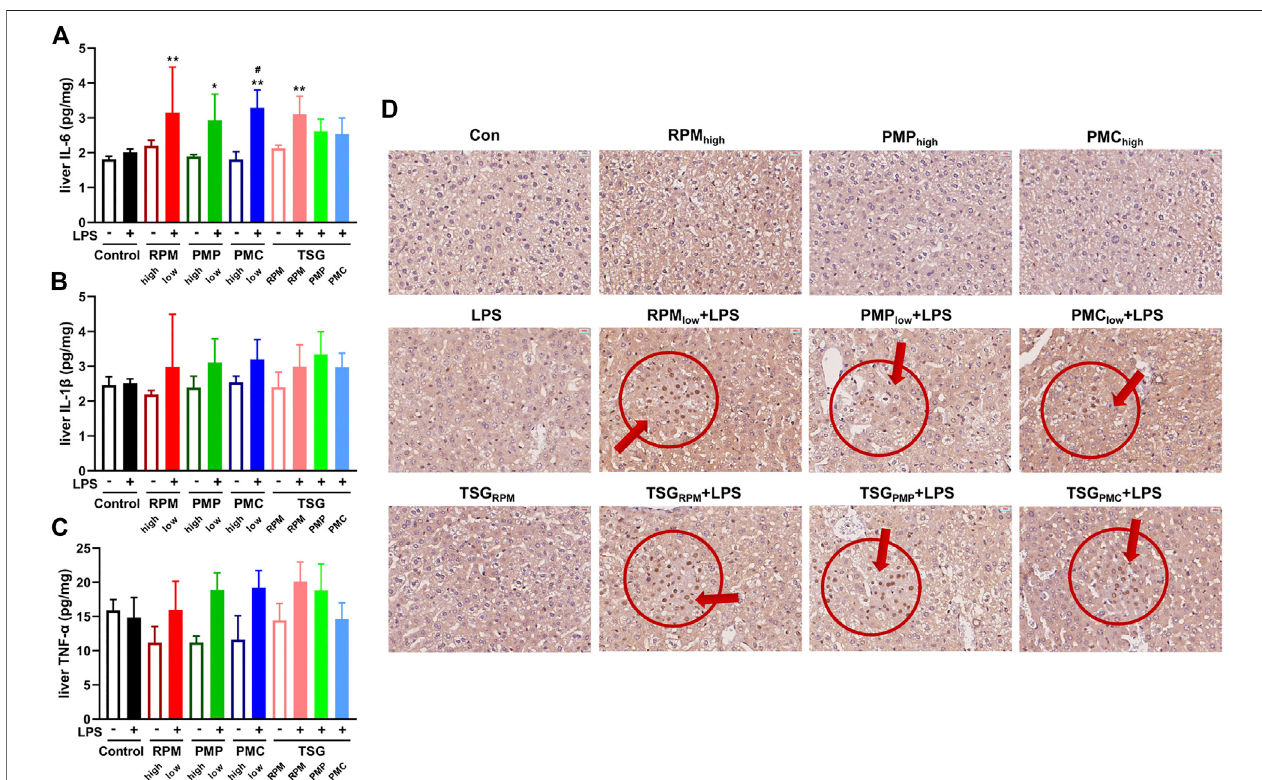
FIGURE 5 | PM- and TSG-induced liver injury develop in LPS-injected mice via NF- κ B signaling. RPM high , PMP high , PMC high : 30 g/kg/d, 14 days, ig. RPM low , PMP low , PMC low : 6 g/kg/d, 14 days, ig. TSG RPM : 0.462 mg/kg/d cis -SG and 40 mg/kg/d trans -SG, 14 days, ig. TSG PMP : 0.45 mg/kg/d cis -SG and 18 mg/kg/d trans - SG,14 days,ig.TSG PMC :0.18 mg/kg/d cis -SGand4.8 mg/kg/d trans -SG,14 days,ig.LPS:0.5 mg/kg,2 hbeforeigonday14,iv.Allmicewereeuthanizedforsample collection 6 h after ig on day 14. The contents of IL-6 (A) , IL-1 β (B) , and TNF- α (C) in the hepatic homogenates of each group by ELISA ( n = 6). Mean ± SD, * p